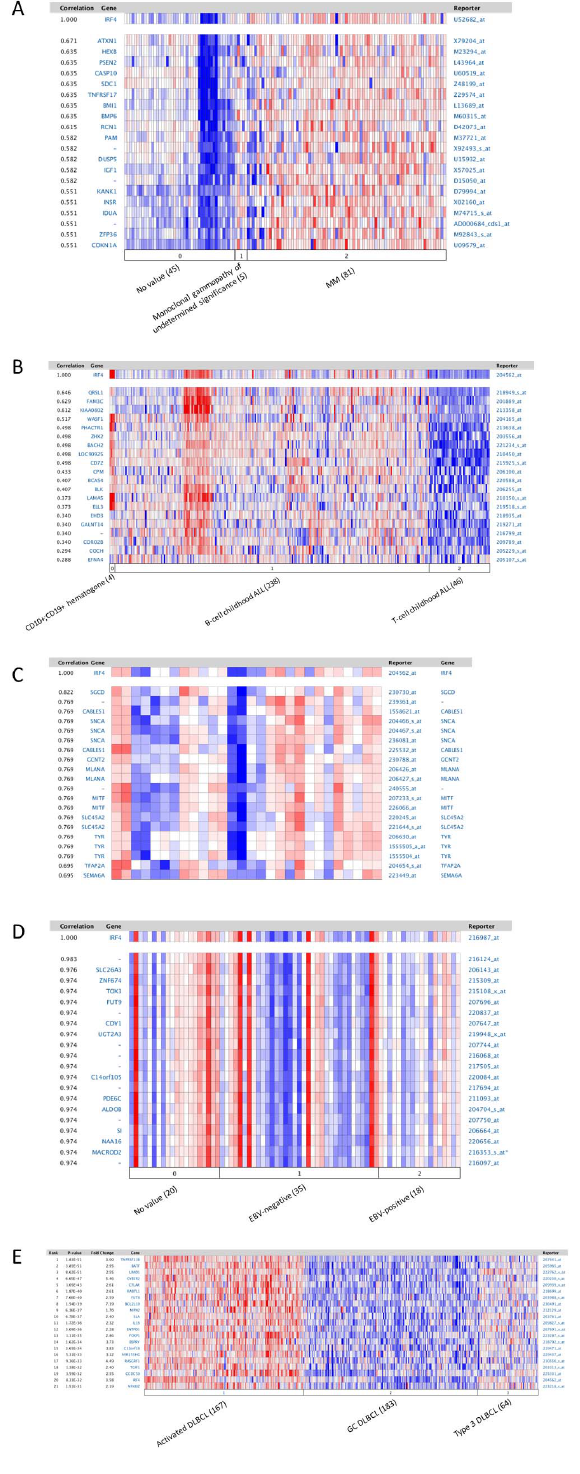
Figure 2. Molecular signature associated with IRF4 in hemato- logical malignancies. A . IRF4-associated gene expression pattern in myeloma. The dataset includes 131 samples [44]. Analysis was performed with default parameters (p value: 10 2 4 , fold change: 2, and gene rank: top 10%). 0. No value (45 samples); 1. Monoclonal gammopathy of undetermined significance (5 samples); 2. Multiple myeloma (81 samples including 74 clinical samples and 7 cell lines). B . IRF4-associated gene expression pattern in leukemia. The dataset includes 288 B- and T-cell acute lymphoblastic leukemia samples [45].